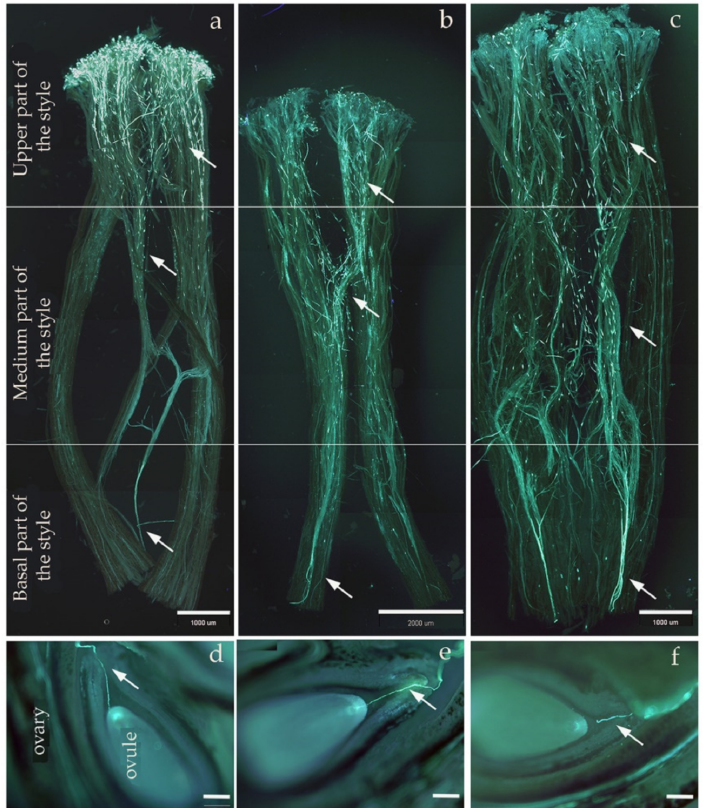
Figure 3. Growth of pollen tubes into certain parts of the pistils of ‘ ˇCaˇcanska Lepotica’ from the pollen of: ( a , d ) ‘ ˇCaˇcanska Lepotica’ stored at − 20 ◦ C; ( b , e ) ‘Valerija’ stored at − 80 ◦ C; ( c , f ) ‘Valjevka’ stored at − 196 ◦ C. Scale bars: ( a , c )—1000 µ m; ( b )—2000 µ m; ( d , e , f )—200 µ m. Arrows—indicate pollen